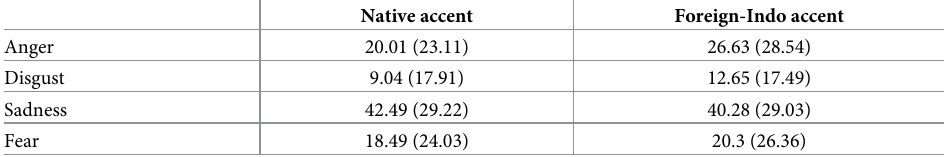
Table 3. Mean scores (SD) for each emotion across Accent (native vs. foreign-Indo).